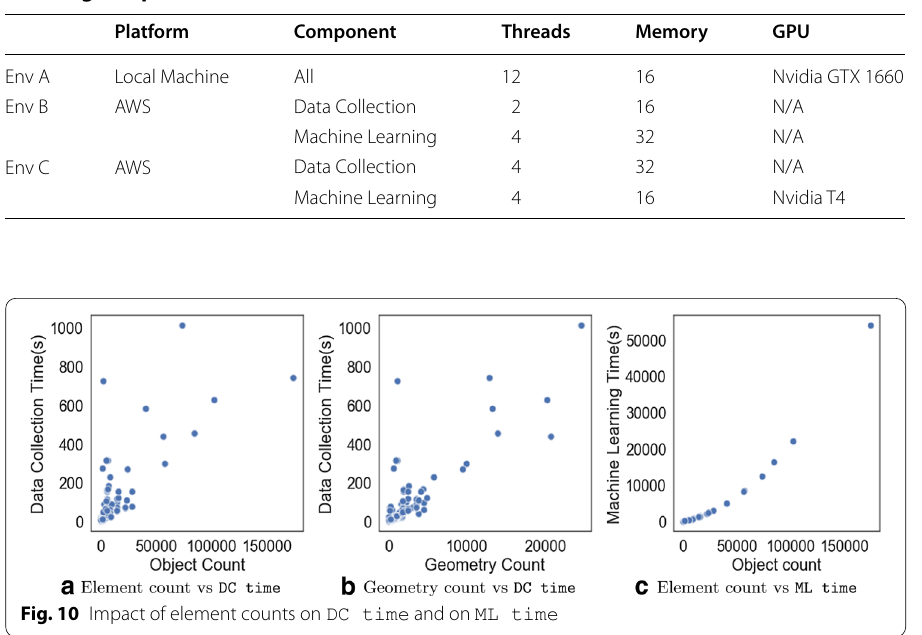
Table 1 Environment list and specification for Data Collection component and Machine Learning component